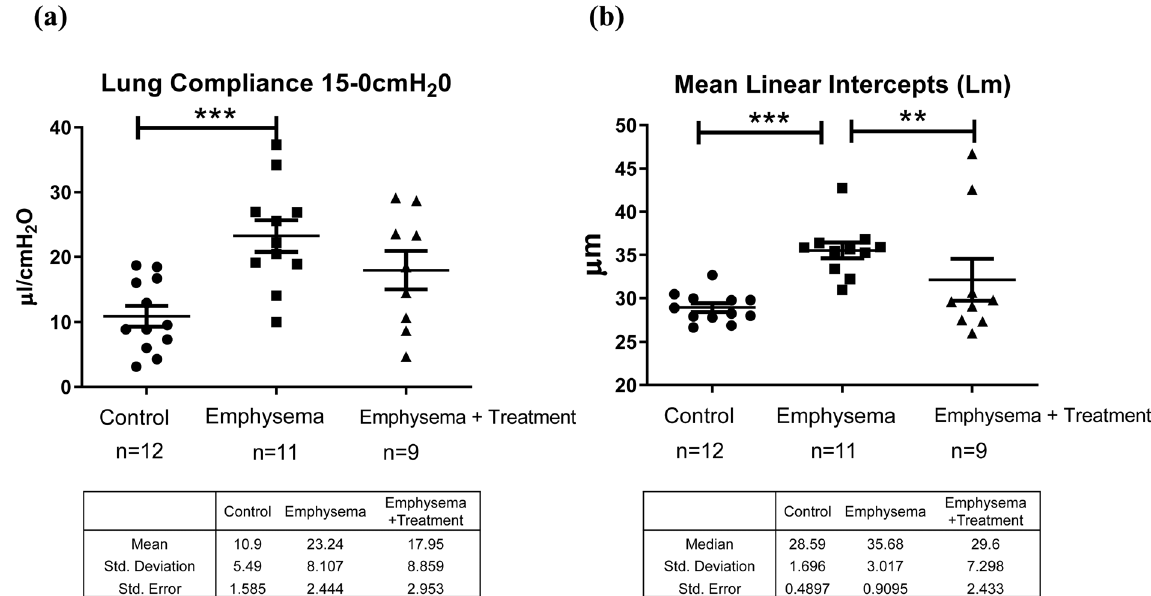
Figure 5. Lung compliance and Lm. ( a ) Lung compliance: The lung compliance was measured by using the water displacement method. Consistent with a decreased stiffness of the lungs, the emphysema group showed a significant increase in compliance compared to the saline group. Lung compliance of the emphysema + treatment group was lower than the emphysema group, albeit not statistically significant. ( b ) Mean linear intercepts (Lm): Compared to the control group, the Lm was significantly increased in the emphysema group while significantly decreased in the emphysema + treatment group. Asterisks above the horizontal lines indicate a significant difference in the comparisons between the groups (**p < 0.01, ***p <